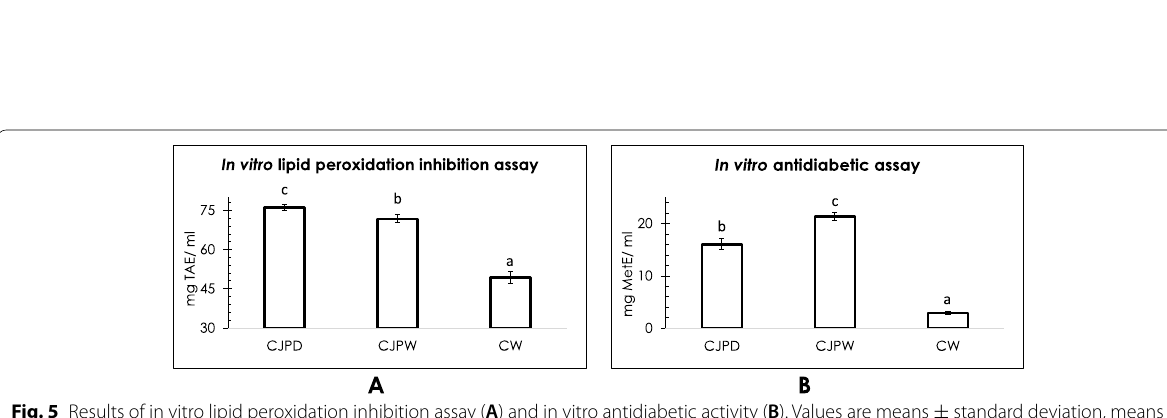
standard deviation, means ±